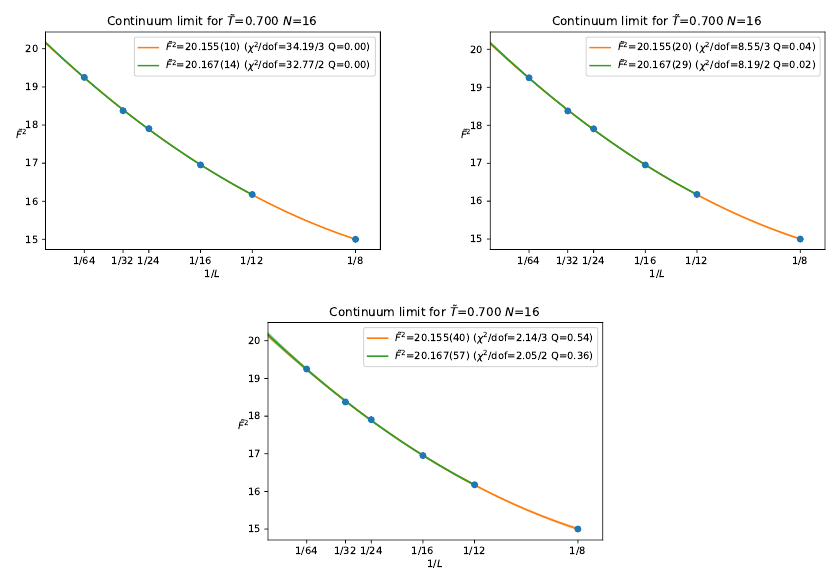
Figure 13. Continuum limit at (cid:12)xed N = 16 and ~ T = 0 : 7 for the ungauged ~ F 2 with and without L = 8 points. Each panel, starting from the top, shows (cid:12)ts to points with in(cid:13)ated error bars by a factor of 1, 2 and 4, respectively. The (cid:12)ts in each panel are consistent, showing that a quadratic extrapolation function works well, even for L = 8, but the quality of the (cid:12)ts is bad. This indicates that our errors are